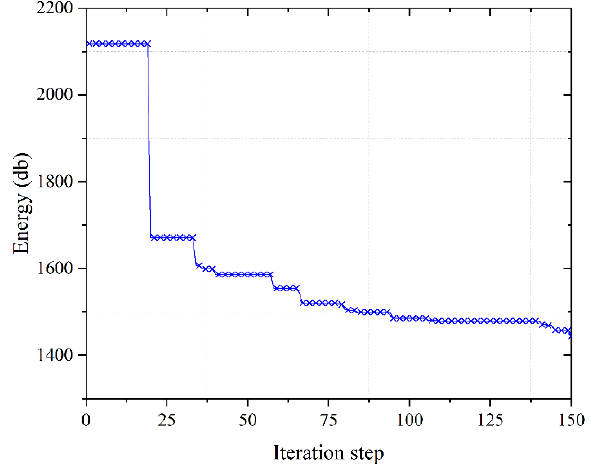
Figure 19. Iterative convergence curve for vibration reduction optimization of the PAF (ROM).